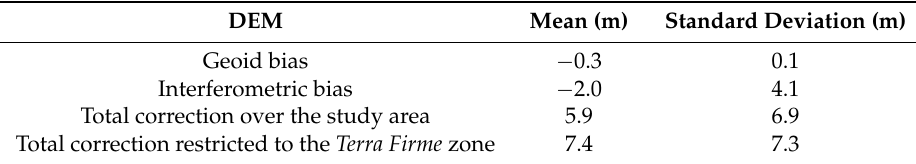
Table 2. DEM vertical accuracy assessment against 10 ground control point (GCP) dataset and river network